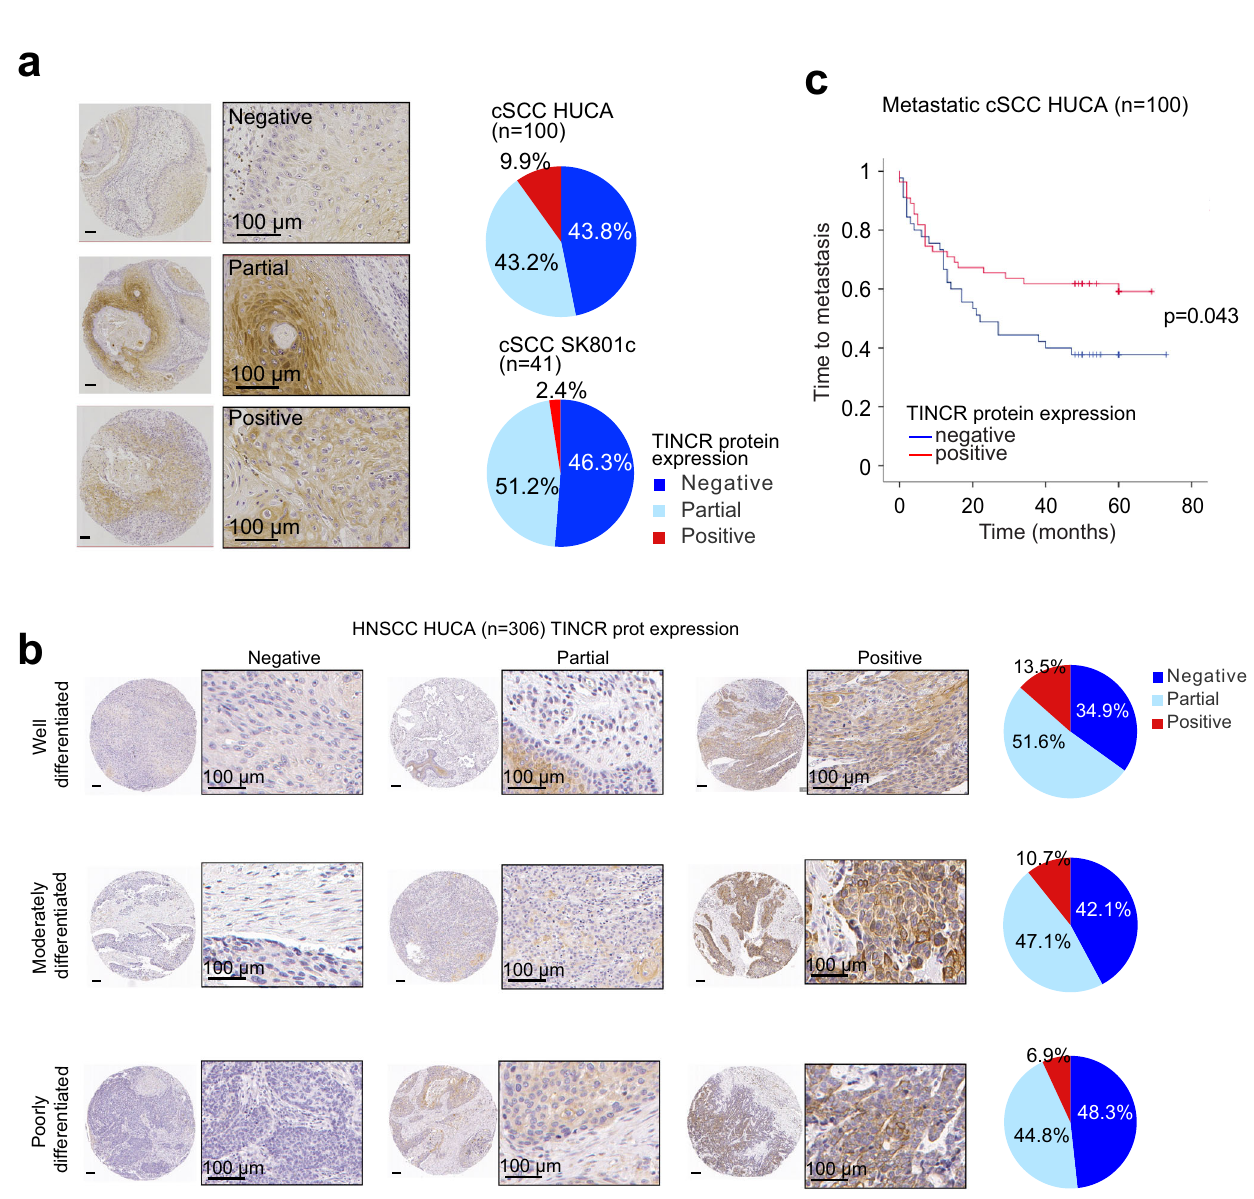
Fig. 4 | Prognostic impact of the loss of TINCR protein expression in human cancer. a Representative images of immunohistochemical analysis of TINCR pro- tein expression in cSCC tumors. Pie chart graphs show the prevalence of different TINCR protein expression patterns in two independent cohorts of cSCC samples. Negative (blue): no detection. Partial (light blue): TINCR expression is limited to differentiated areas of the tumor. Positive (red): diffuse TINCR staining. b Representative images of the different staining patterns of TINCR detected by